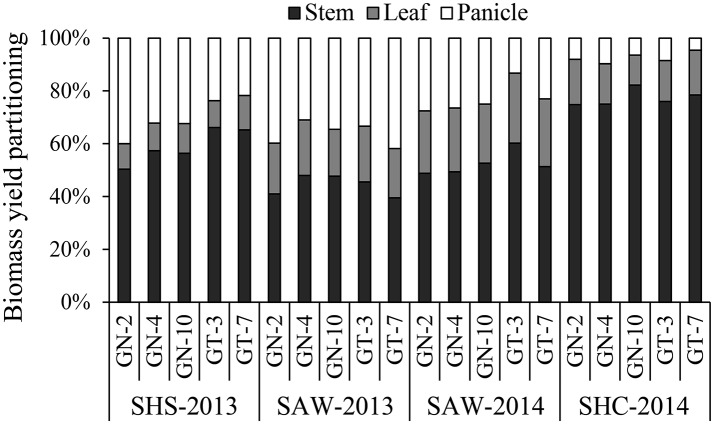
Dry biomass yield partitioning of energy sorghum hybrids as determined by the weight fractions of stem, leaf, and panicle for different experimental sites of sub-humid climate and saline-land (SHS), semi-arid climate and wasteland (SAW), and sub-humid climate and cropland (SHC) in 2013 and 2014.